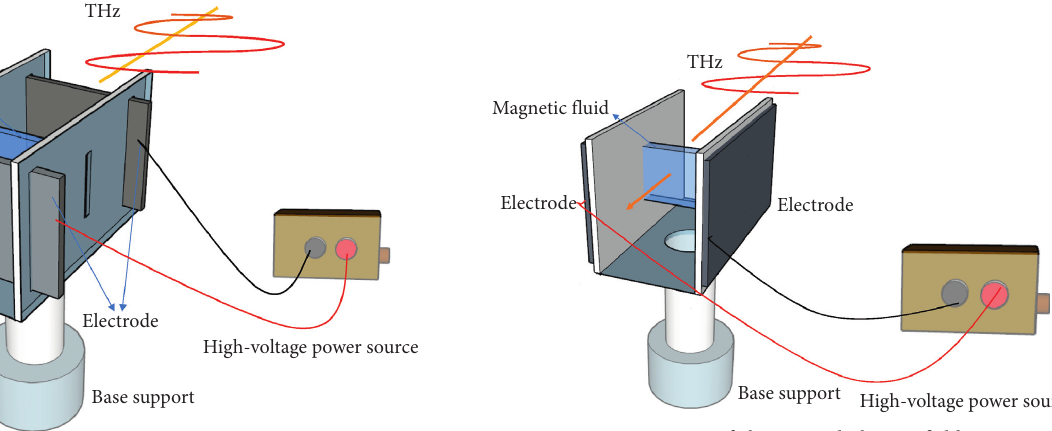
Figure 5: Diagram of the parallel electric field system.